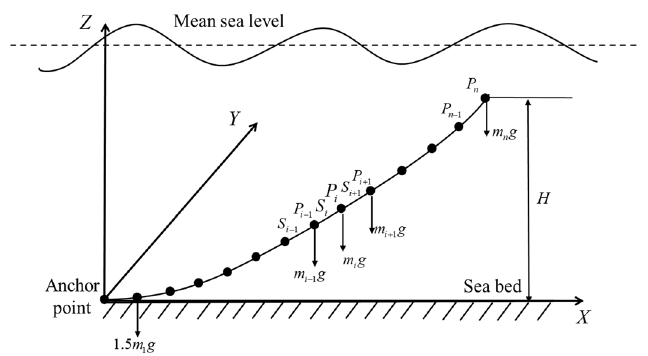
Figure 3. Description of lumped-mass method for mooring system.